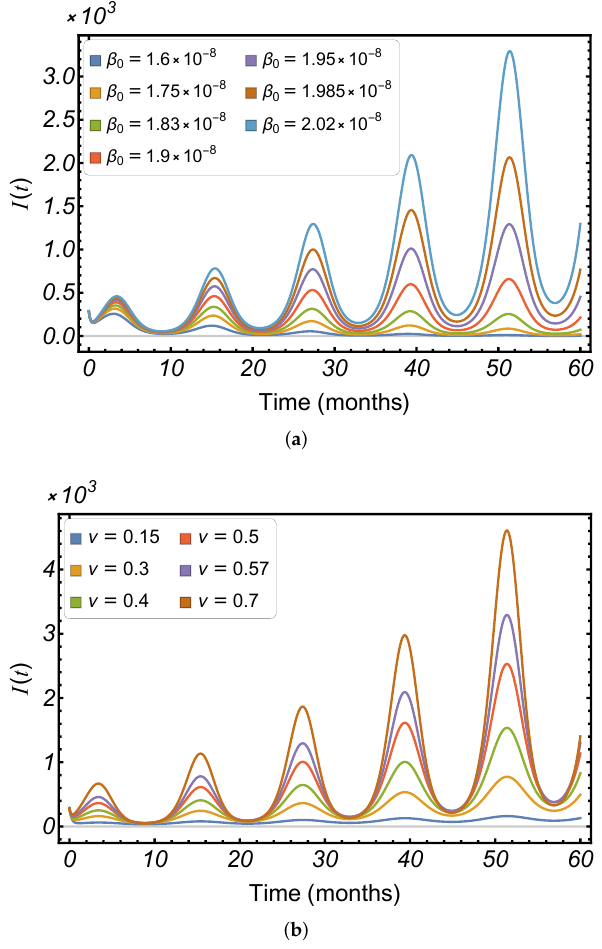
Figure 5. Infectious population with differing values in ( a ) the baseline contact rate β 0 and ( b ) incu- bation rate ν , utilizing the parameter values listed in Table 2.